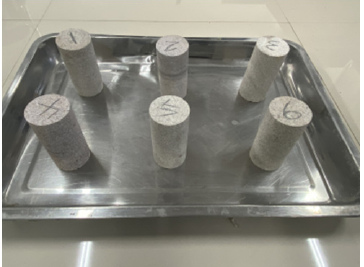
Figure 2. Sandstone specimens after high temperature treatment.